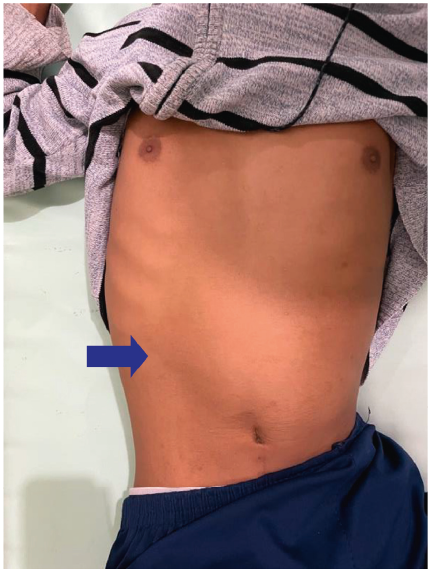
Figure 1: Physical examination showing bowel contour in the epigastric region and LUQ.